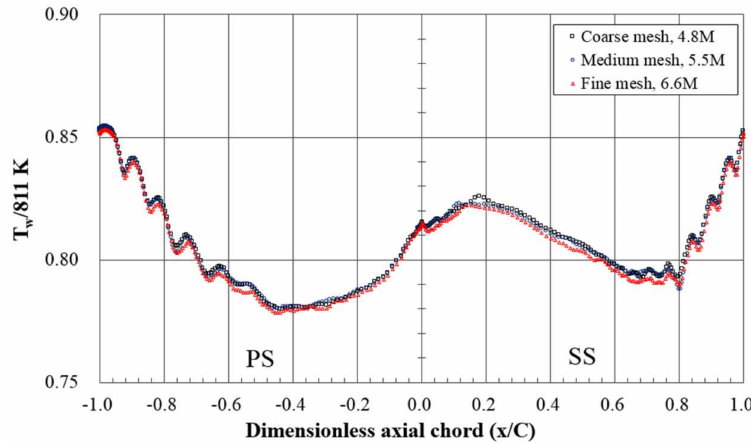
Figure 3. Comparisons of three mesh number strategies for surface temperature distributions at midspan. PS: pressure side; SS: suction side.